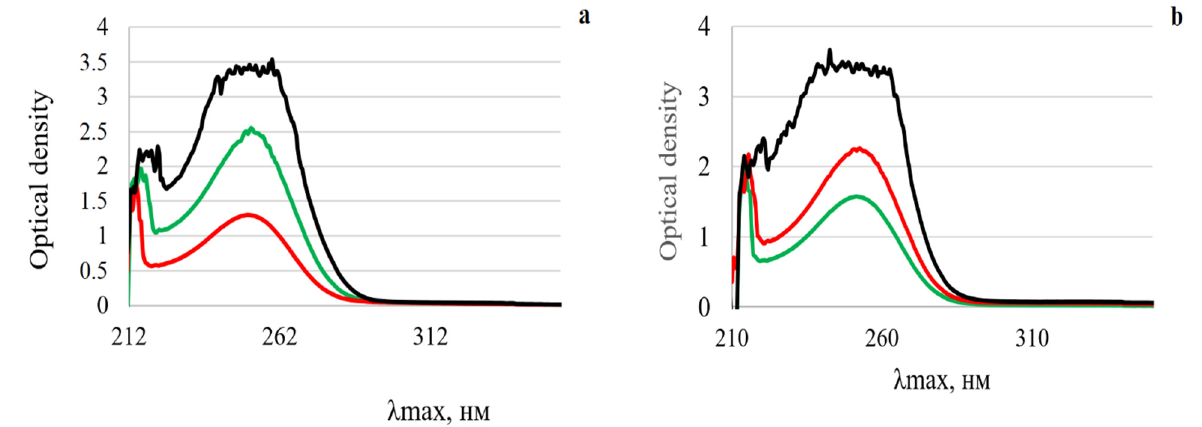
Figure 4. UV spectra of ( a ) MSGA:BG complexes and ( b ) GA:BG complexes: lines in red— Figure MSGA/GA:BG 10:1, lines in green—MSGA/GA:BG 20:1, lines in black—MSGA/GA:BG 50:1.